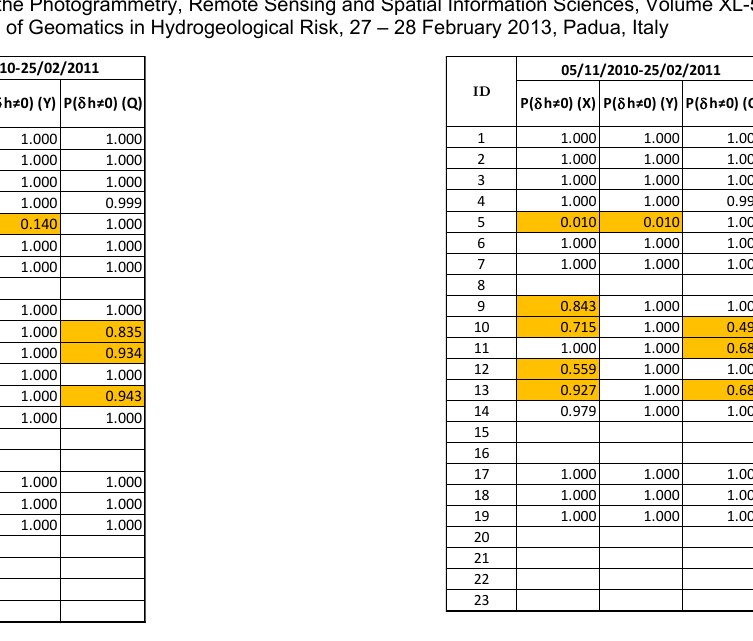
Table 12. Results of Bayesian analysis with prior data μ = 0.01